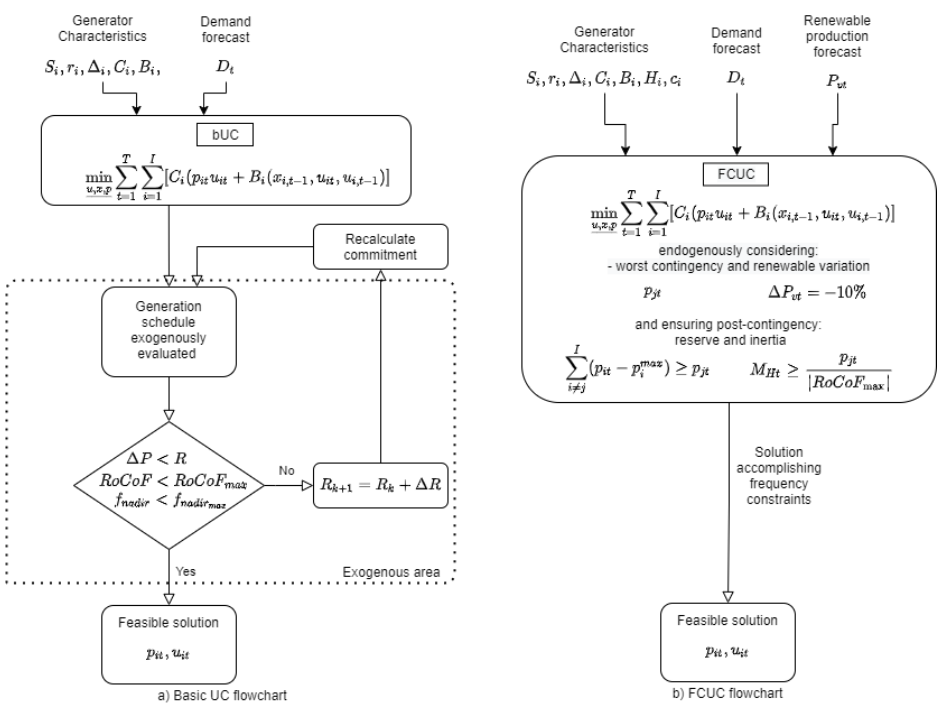
Figure 1. ( a ) bUC flowchart; ( b ) FCUC